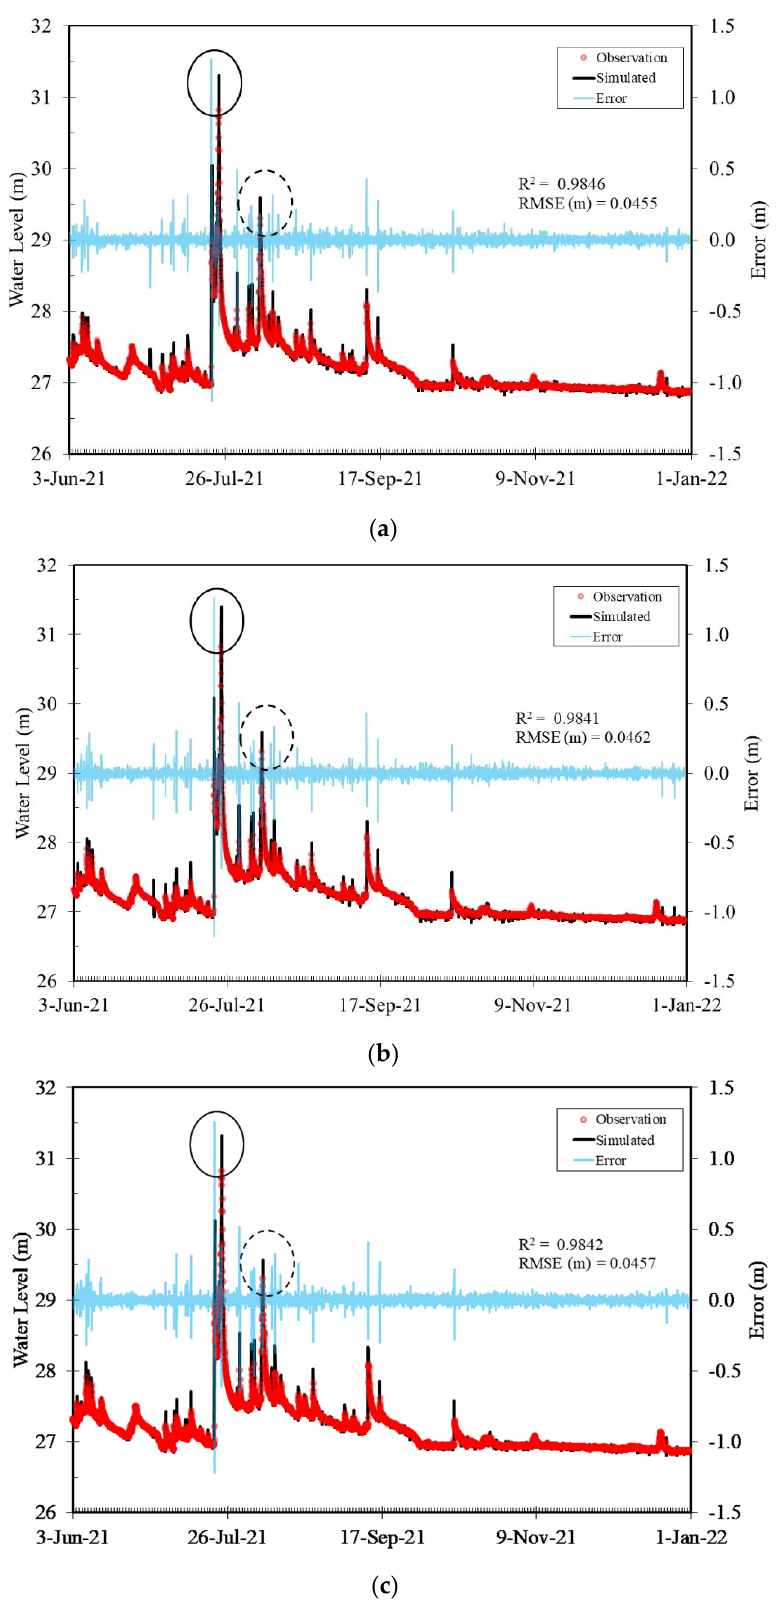
Figure 11. ( a - c ) Comparison of simulation and observed water levels at TR_S2 of the Touciaan River for lead times t + 1 h, t + 2, and t + 3 h, respectively.